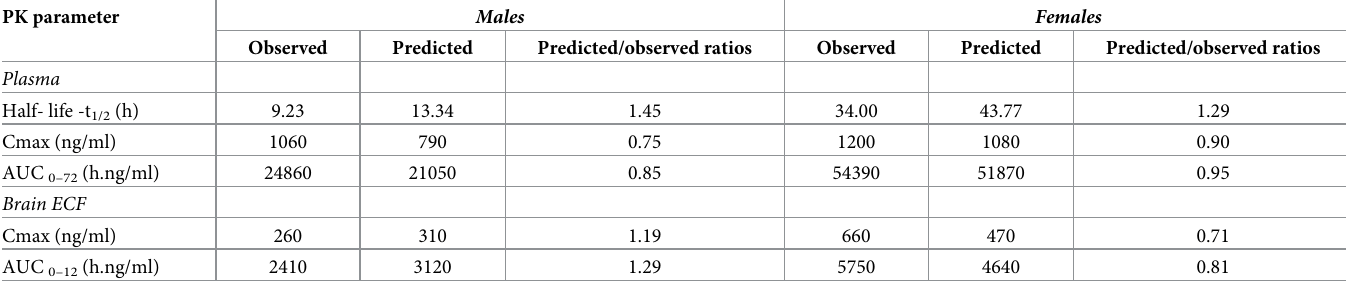
Table 4. Male versus female observed and predicted pharmacokinetic parameter estimates in both brain and plasma of Sprague-Dawley rats following administra- tion of a single dose of letrozole (4 mg/kg) obtained by NCA. PK parameter Males Females Observed Predicted Predicted/observed ratios Observed Predicted Predicted/observed